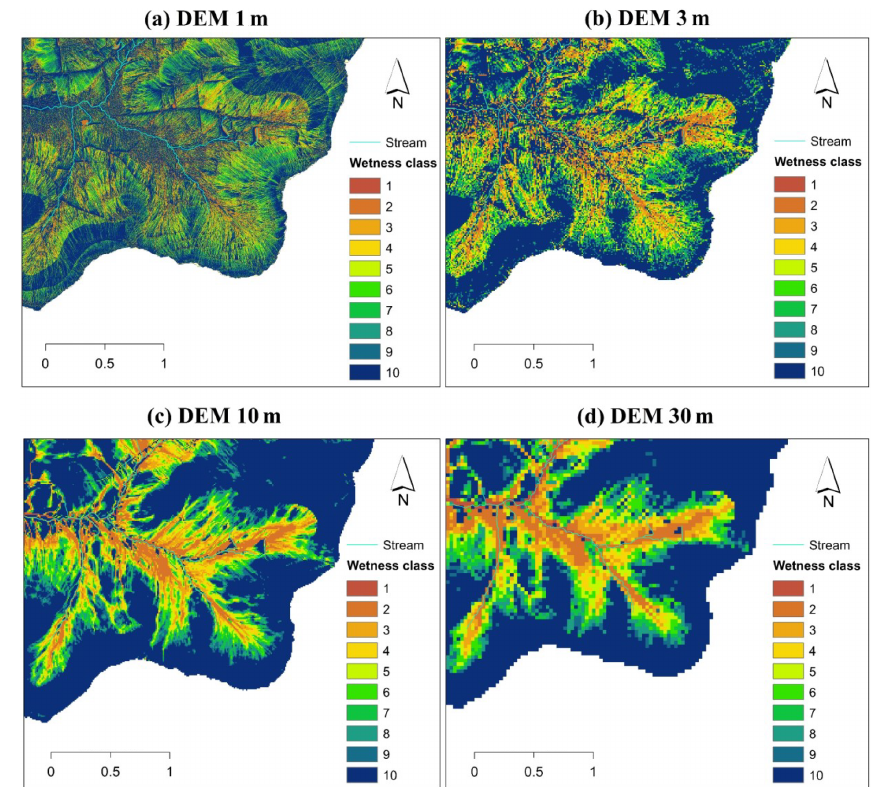
Figure 4. Wetness maps created from DEMs with different